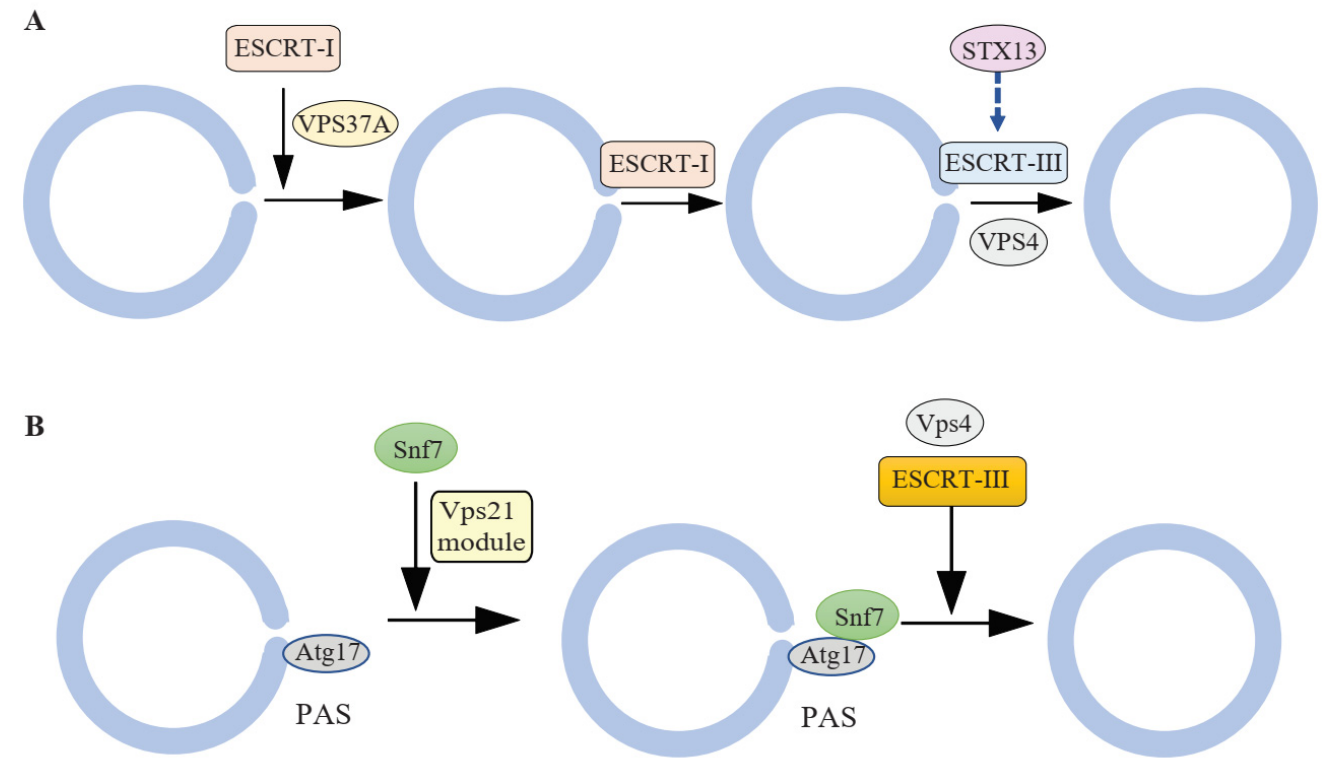
Figure 2. Model for ESCRT-mediated autophagosome closure. ( A ) In mammalian cells, the ESCRT-I complex translocates to the isolation membrane in a VPS37A-dependent manner, followed by recruitment of ESCRT-III. ESCRT-III and the AAA-ATPase VPS4 facilitate autophagosome closure. Syntaxin13 is a genetic modifier of the ESCRT-III component CHMP2B and functions upstream of ESCRT-III in autophagosome closure, although there is no direct physical interaction between Syntaxin13 and CHMP2B. ( B ) In budding yeast, the ESCRT-III subunit Snf7 interacts with the scaffold protein Atg17 in a Vps21-dependent manner, which results in the recruitment of ESCRT-III. ESCRT-III and Vps4 catalyze the closure of the isolation membrane to form a sealed autophagosome.